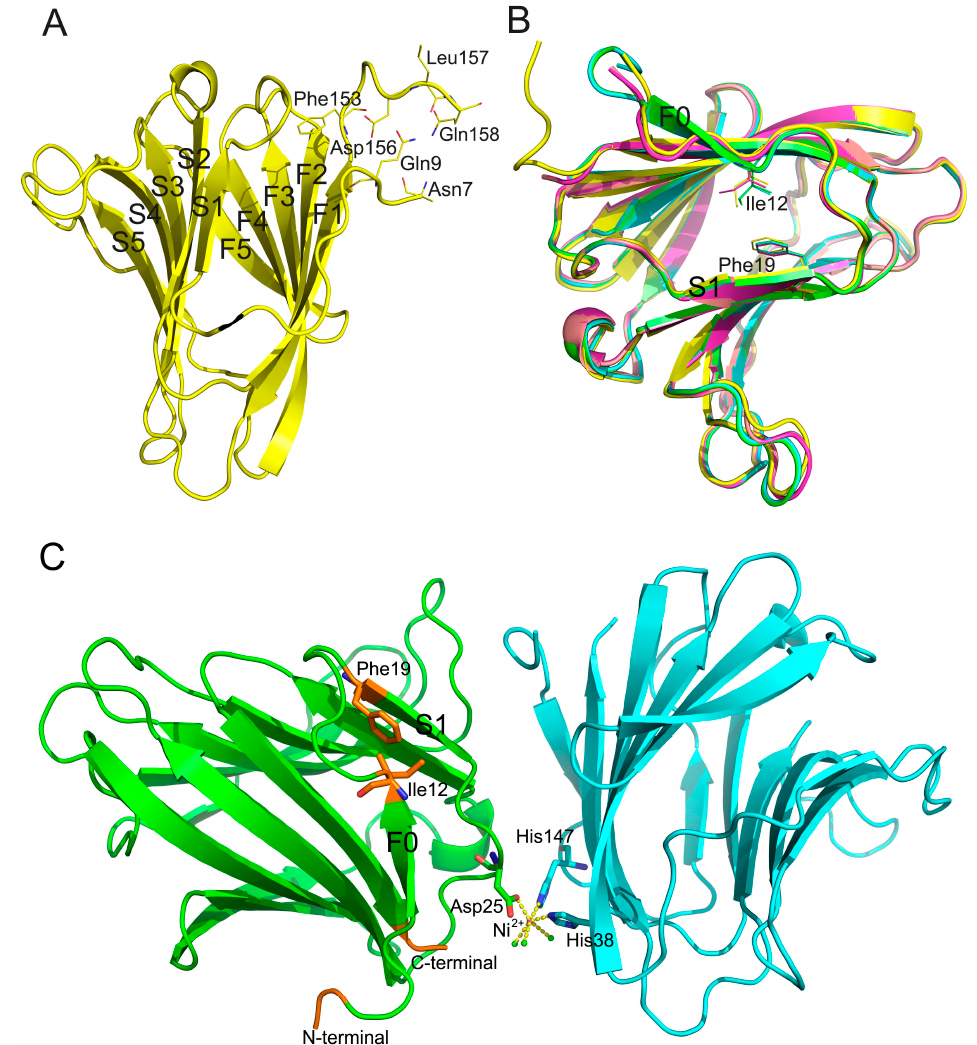
Figure 3. Crystal structures of Gal-8_1-186. ( A ) The N-terminal tail interacts with the bottom of Gal-8 linker (structure 1); ( B ) Phe19 could interact with Ile12 through van der Waals forces (structure 1: yellow ; structure 2: purple ; structure 3: pink ; structure 4: cyan ; structure 5: green ); ( C ) Ni 2+ was found to form a complex with Asp25 and two histidine residues (His38 and His147) from another Gal-8N molecule. Two Gal-8 N-terminal CRDs from two asymmetric units were labeled by green and cyan. This figure was generated by using structure 4 (PDB: 5GZF). One pink ball indicates Ni 2+ . Three green balls indicate water molecules. N-terminal and C-terminal of the structure are close to each other and are labeled by gold. C-terminal of the structure is also the starting point of the linker.